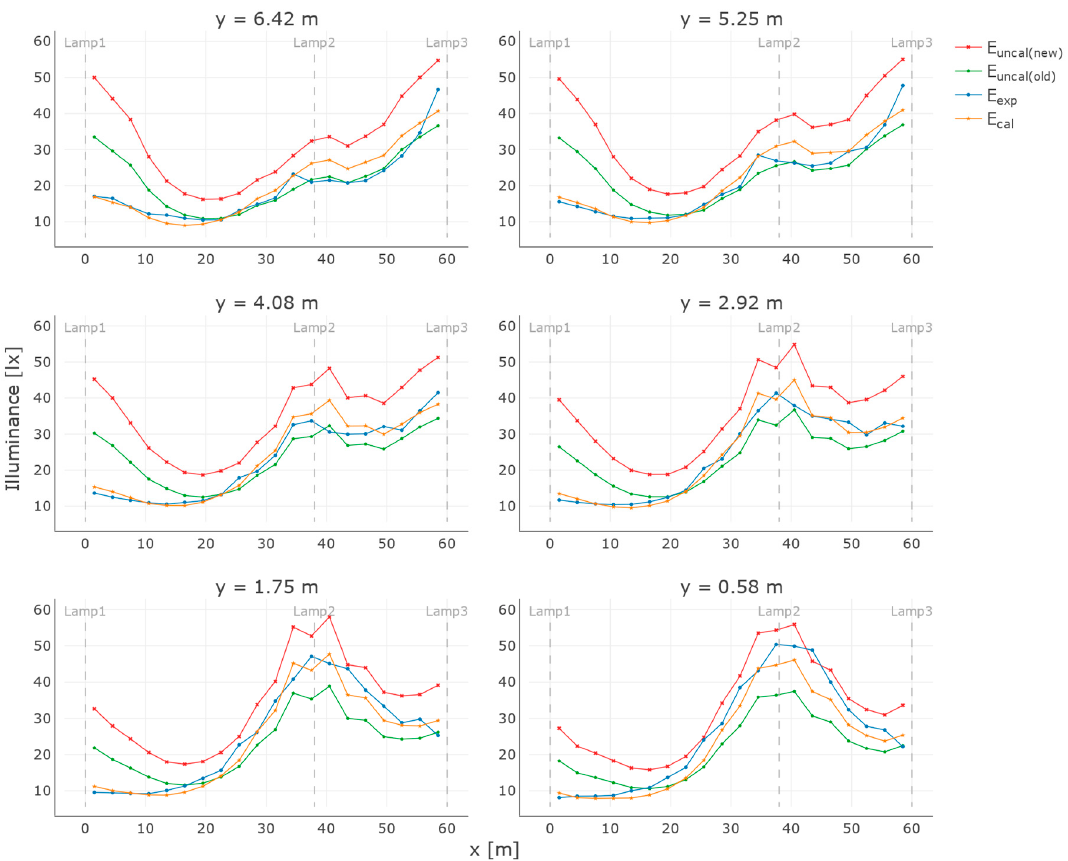
Figure 9. Illuminance in longitudinal sections of the road. E exp : illuminance collected experimentally; E cal and E uncal ( old ) : simulated illuminance from the calibrated and uncalibrated model; and E uncal ( new ) : simulated illuminance considering recently installed lamps without losses.